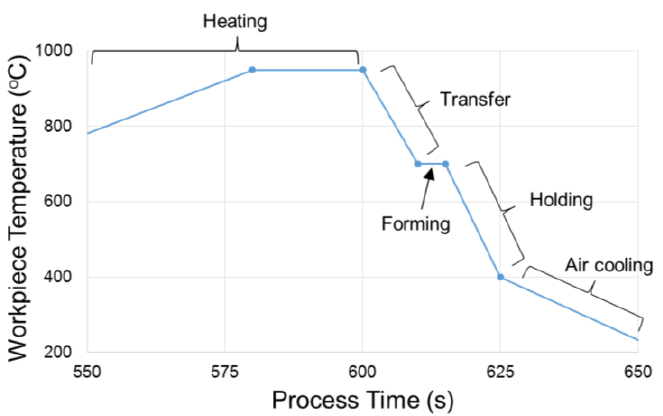
Figure 4. Schematic temperature-time profile of the entire hot stamping test process for T-type parts.